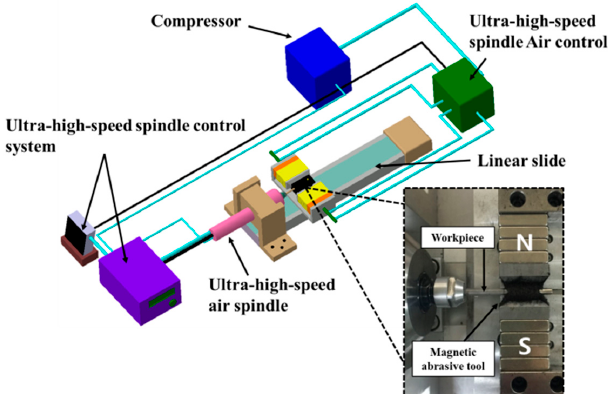
Figure 3. Photographic view of the ultra-high-speed magnetic abrasive machining (UHSMAM) experimental setup. Table 1. Mechanical properties and chemical composition of the workpiece.